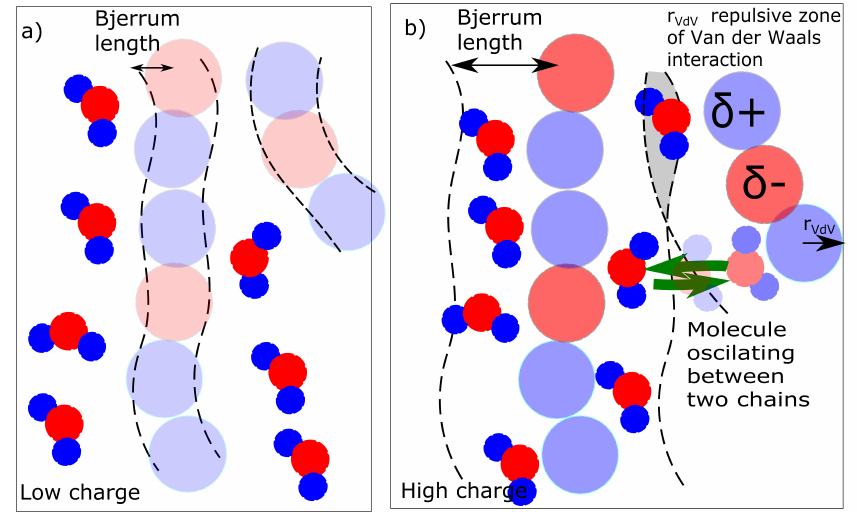
Figure 8. Solvation of macromolecular chain ( a ) low charge on chain-nonsolvated chain; ( b ) high charge (solvated) chain. Volume Inside circles-zone of van der Waals repulsion, dashed: Zone of solvation by Bjerrum